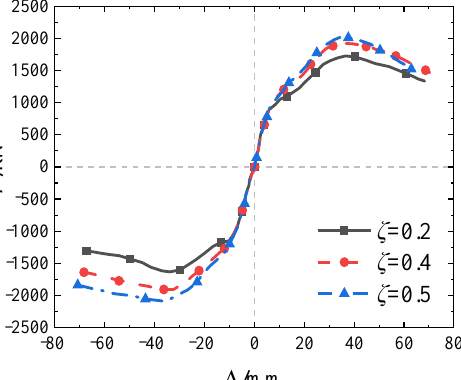
Figure 24. Load–displacement skeleton curves of models with different axial pressure Figure 24. Load – displacement skeleton curves of models with different axial pressure ratios.